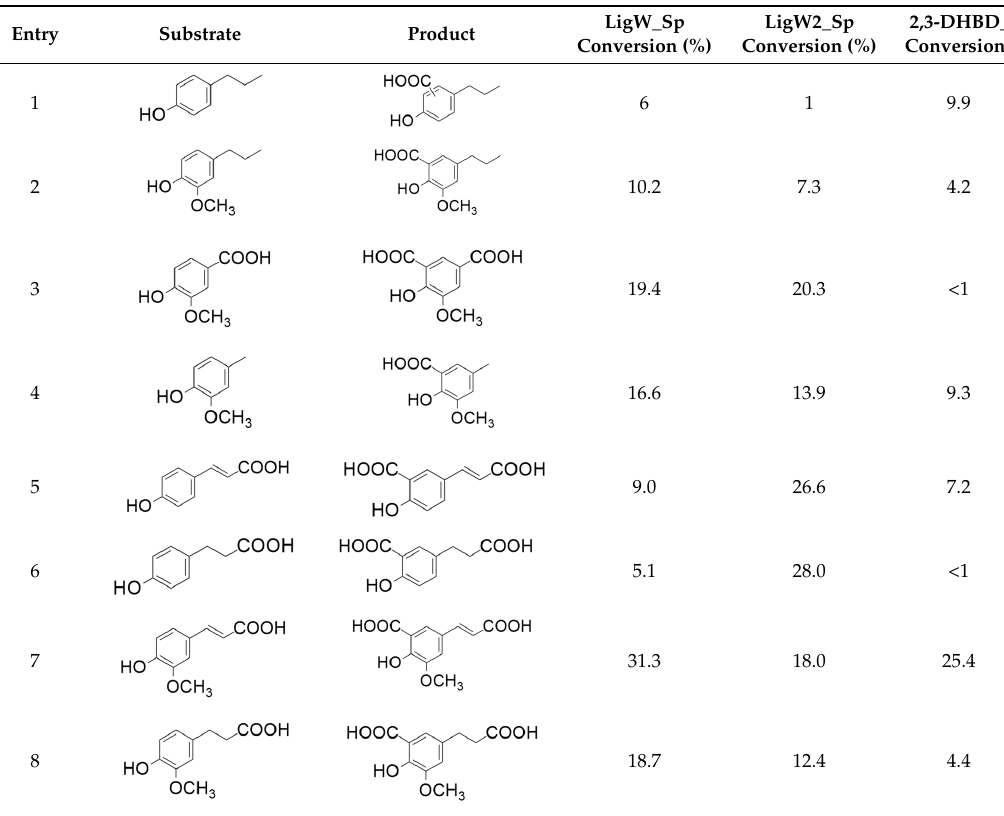
Table 8. Phenols and phenolic acids potentially obtainable from lignin depolymerization carboxylated by LigW_Sp, LigW2_Sp, and 2,3-DHBD_Ao enzymes. Adapted with permission from [73]. Copyright 2018, Elsevier.